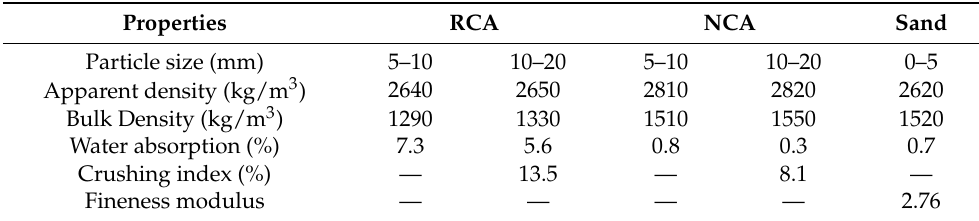
Figure 3. Particle dimension distributions of aggregates: ( a ) Coarse aggregates; ( b ) Fine aggregates. Table 1. Physical properties of RCAs, NCAs, and sand.